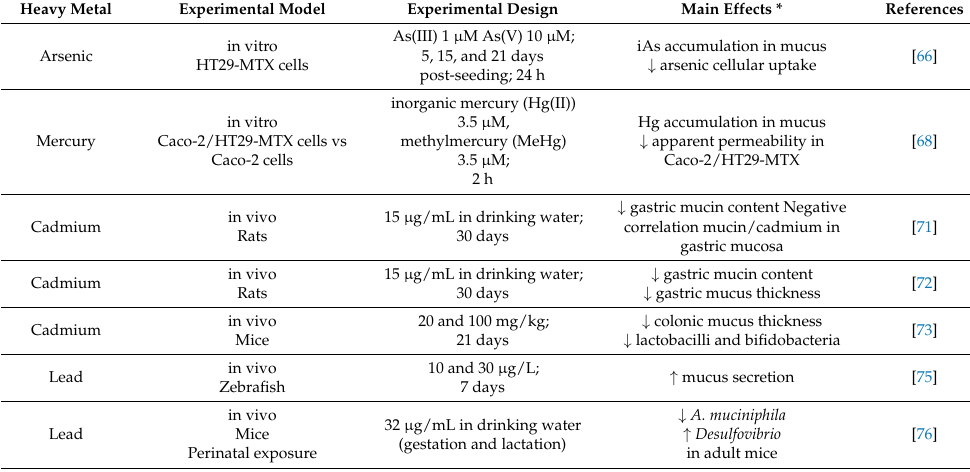
Table 1. Effects of heavy metals on mucus and mucophilic bacteria in the